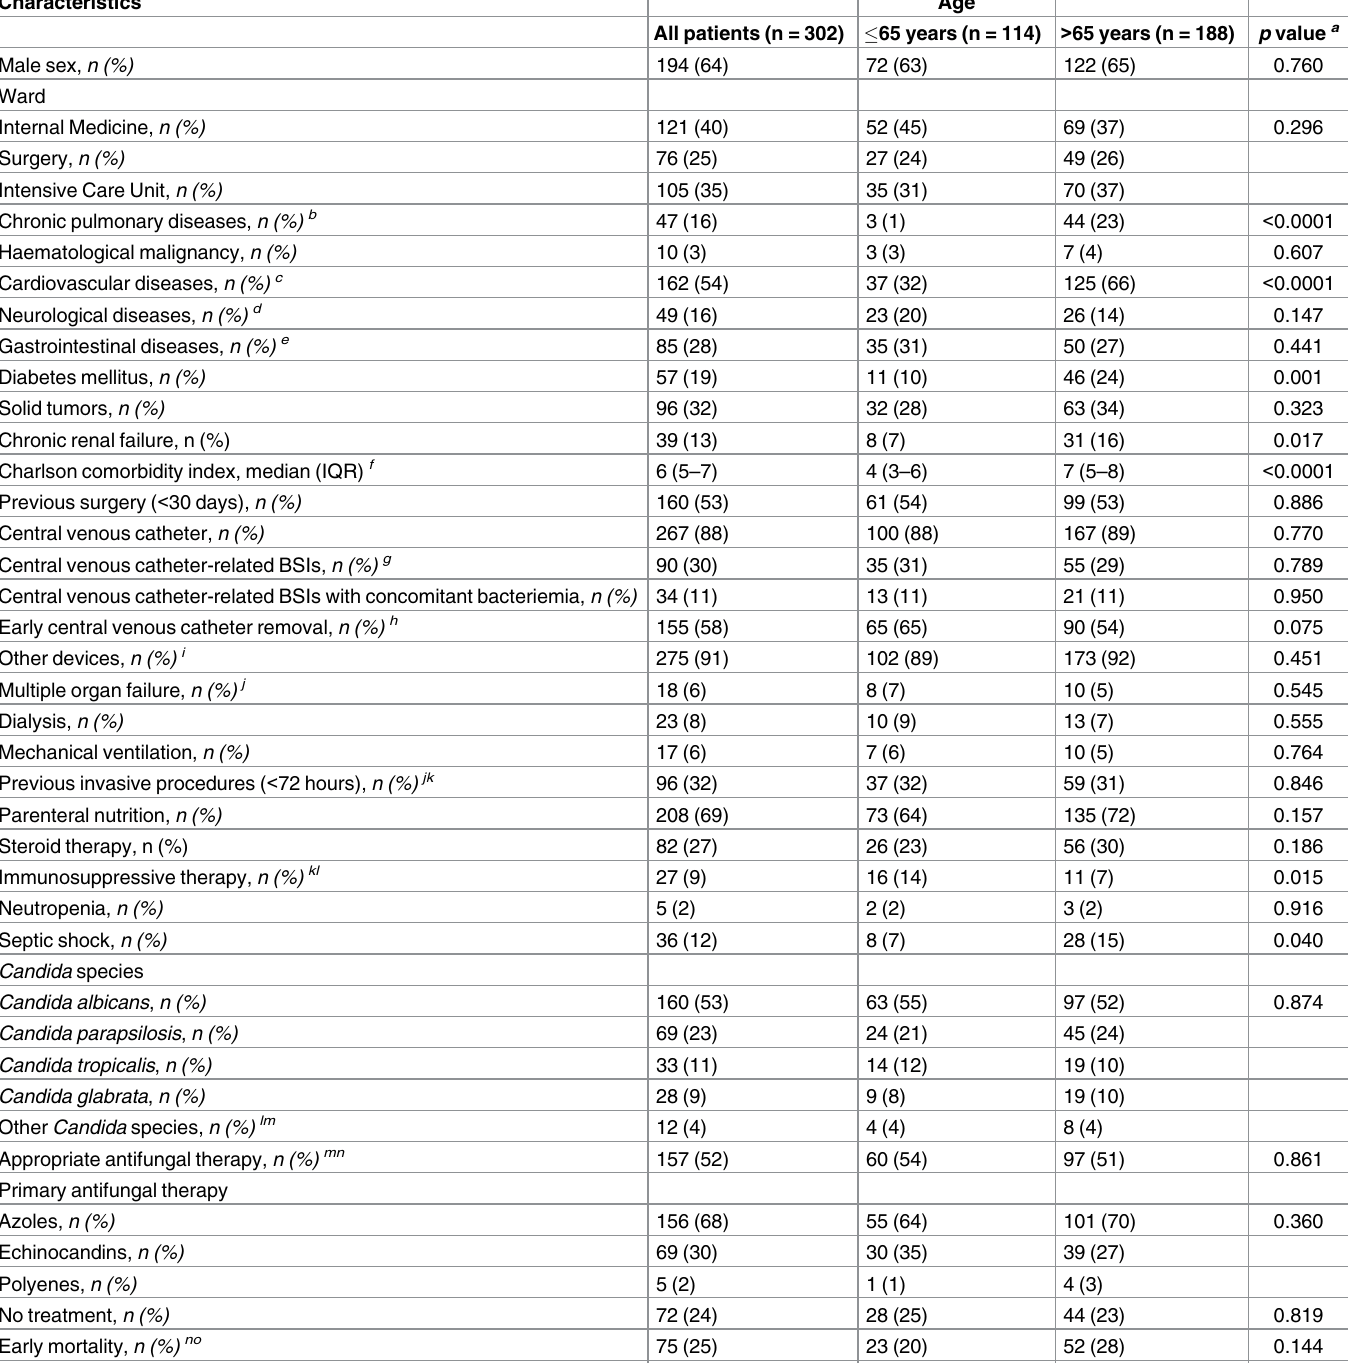
Table 1. Demographics and clinical characteristics of 302 patients with BSIs due to Candida species considered in this study.